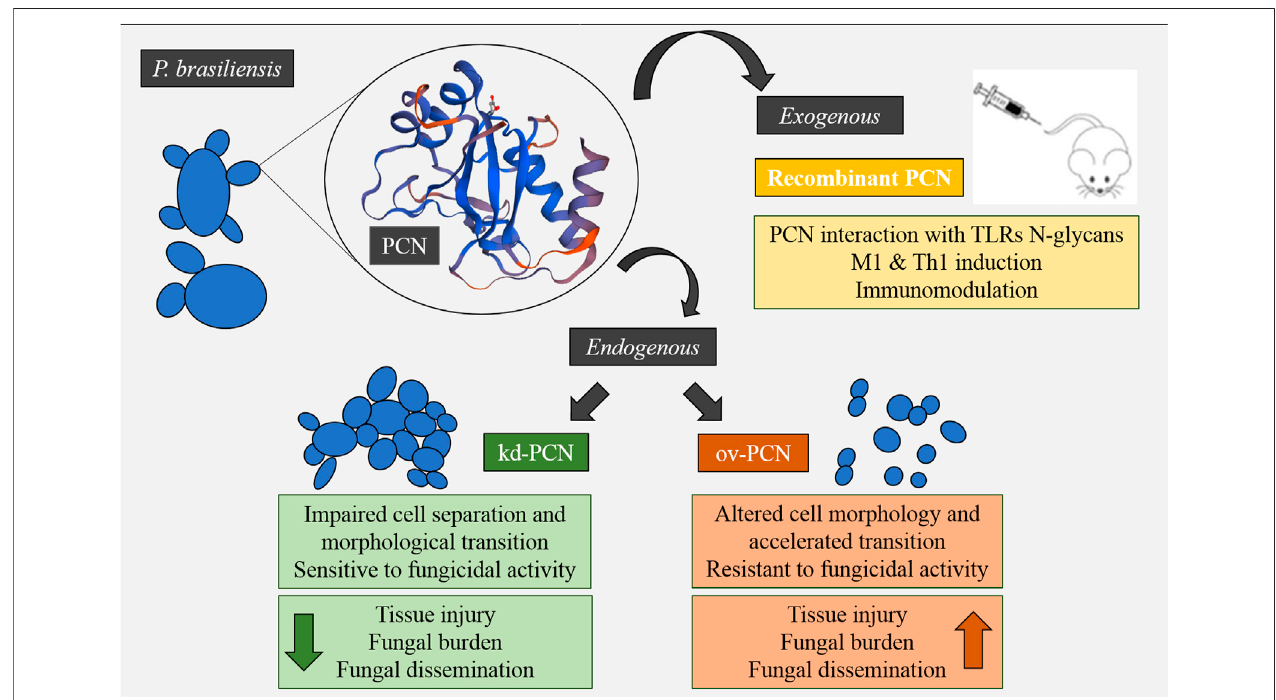
FIGURE 2 | Concise model of the effect of exogenous and endogenous PCN on fungal virulence and modulation of the host ’ s immune response.